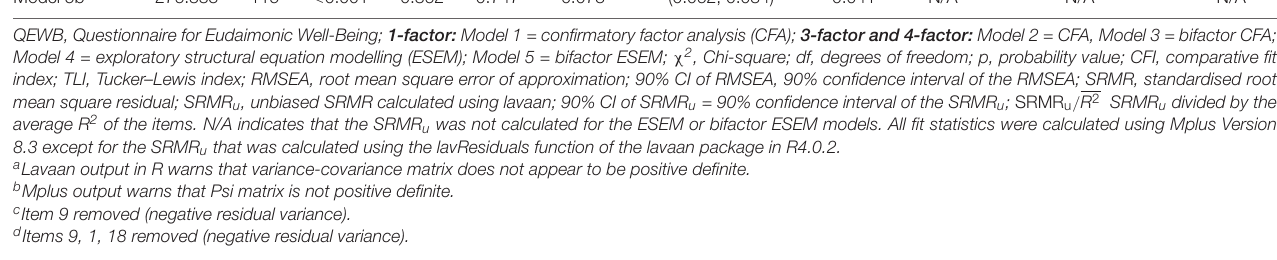
TABLE 3 | Standardised factor loadings and omega coefficients for the final preferred 3-factor models of the QEWB (Samples 1, 2, and 3). Sample 1: QEWB-English Sample 2: QEWB-Afrikaans Sample 3: QEWB-Setswana bifactor